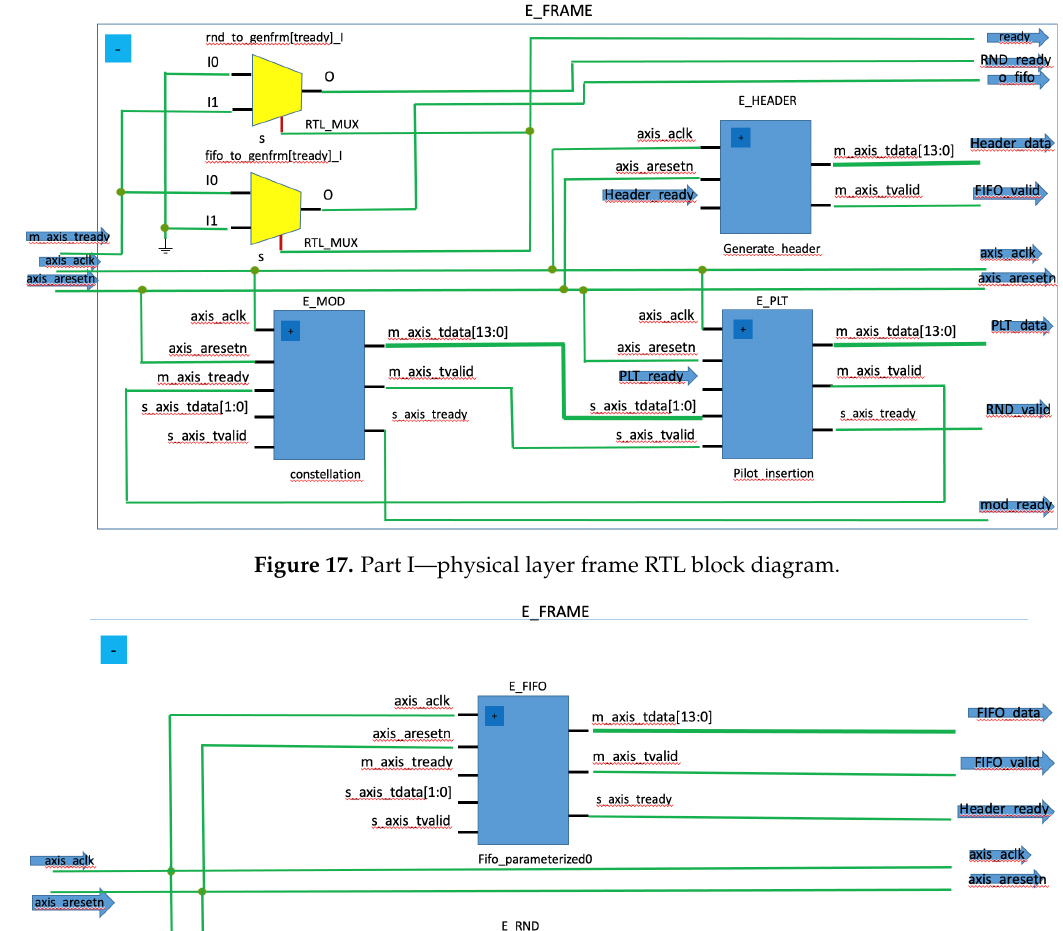
Figure 16. SCCC encoder block diagram. The S2P block is serial to the parallel block.